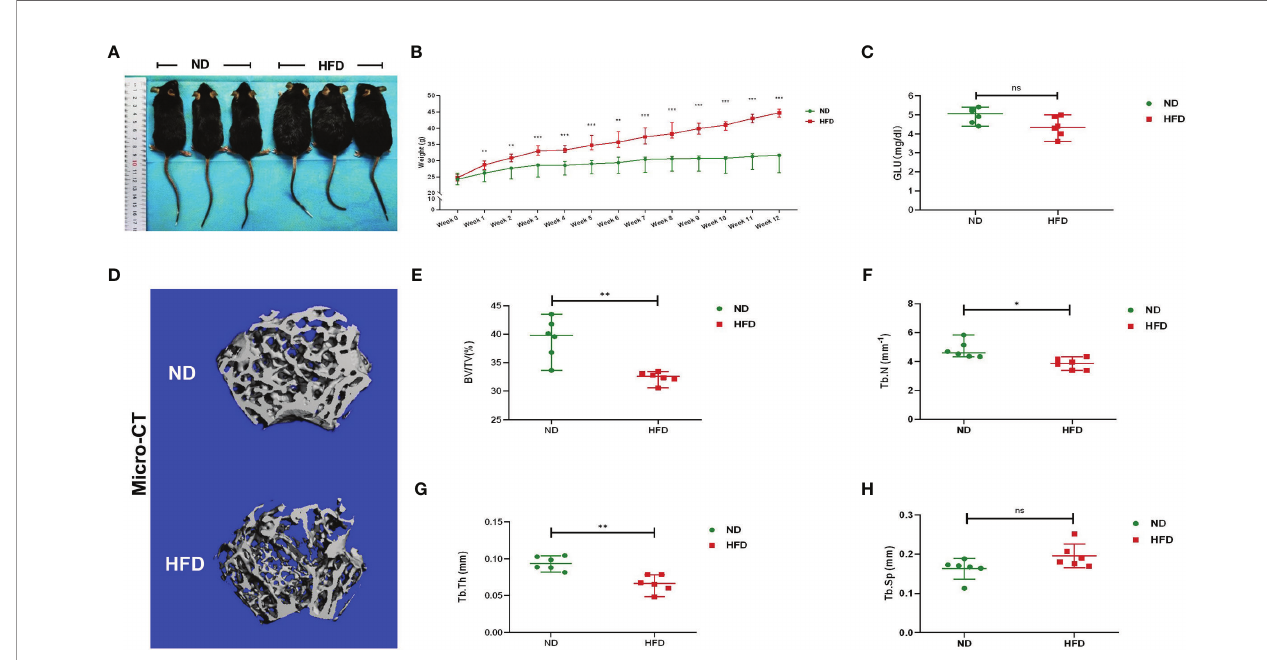
FIGURE 1 | High-fat diet induced obesity and bone loss in mice. (A) Photographs of mice in each group after a 12-week dietary intervention of ND or HFD. (B) Body weight curves of mice after dietary intervention (n = 6). (C) Fasting blood glucose of the two groups (n = 6). (D) Representative images for micro-CT 3D reconstruction (scale bar = 100 mm). (E – G) Trabecular bone parameters at the distal femoral metaphysis, including BV/TV, Tb. N, Tb. Th, and Tb. Sp after ND or HFD treatment (n = 6). Data were expressed as mean ± SD. * P < 0.05, ** P < 0.01, *** P < 0.001; ns, no signi fi